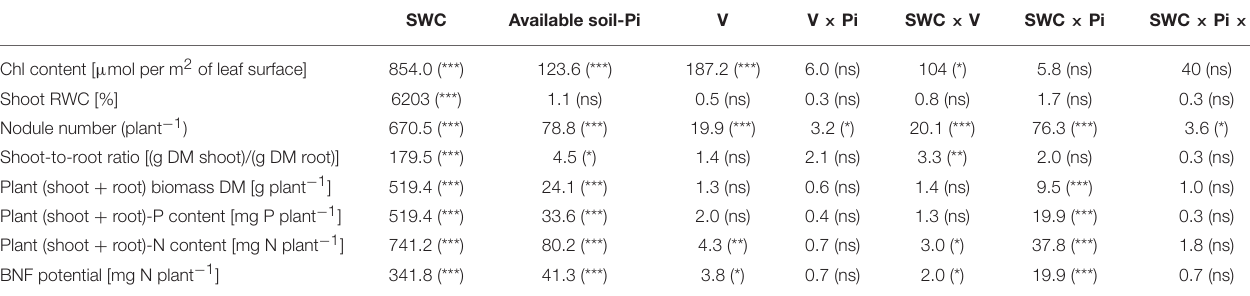
TABLE 1 | Results of the three-way ANOVA testing the effects of soil water conditions (SWC; two levels; WW, well-watered; WD, water deficit), available soil-phosphate (Pi) levels (three levels; low available soil-Pi, moderate available soil-Pi and high available soil-Pi), cowpea varieties (V, nine varieties), and their interactions on chlorophyll (Chl) content, shoot relative water content (RWC), nodule number, biomass production, biological nitrogen fixation (BNF) potential, plant-N and -P contents of cowpea